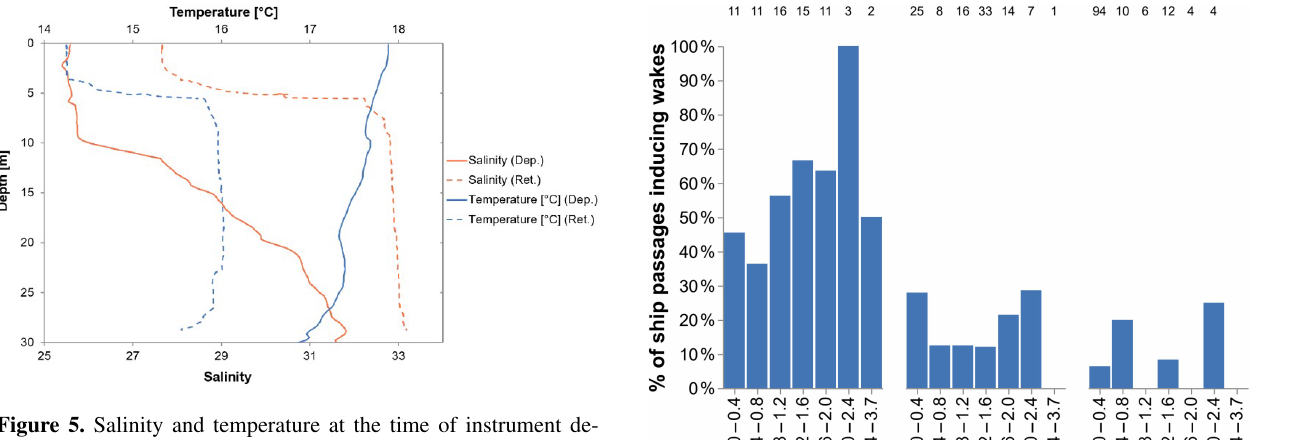
Figure 5. Salinity and temperature at the time of instrument de- ployment (28 August 2018; solid lines) and retrieval (25 Septem- ber 2018; dashed lines).